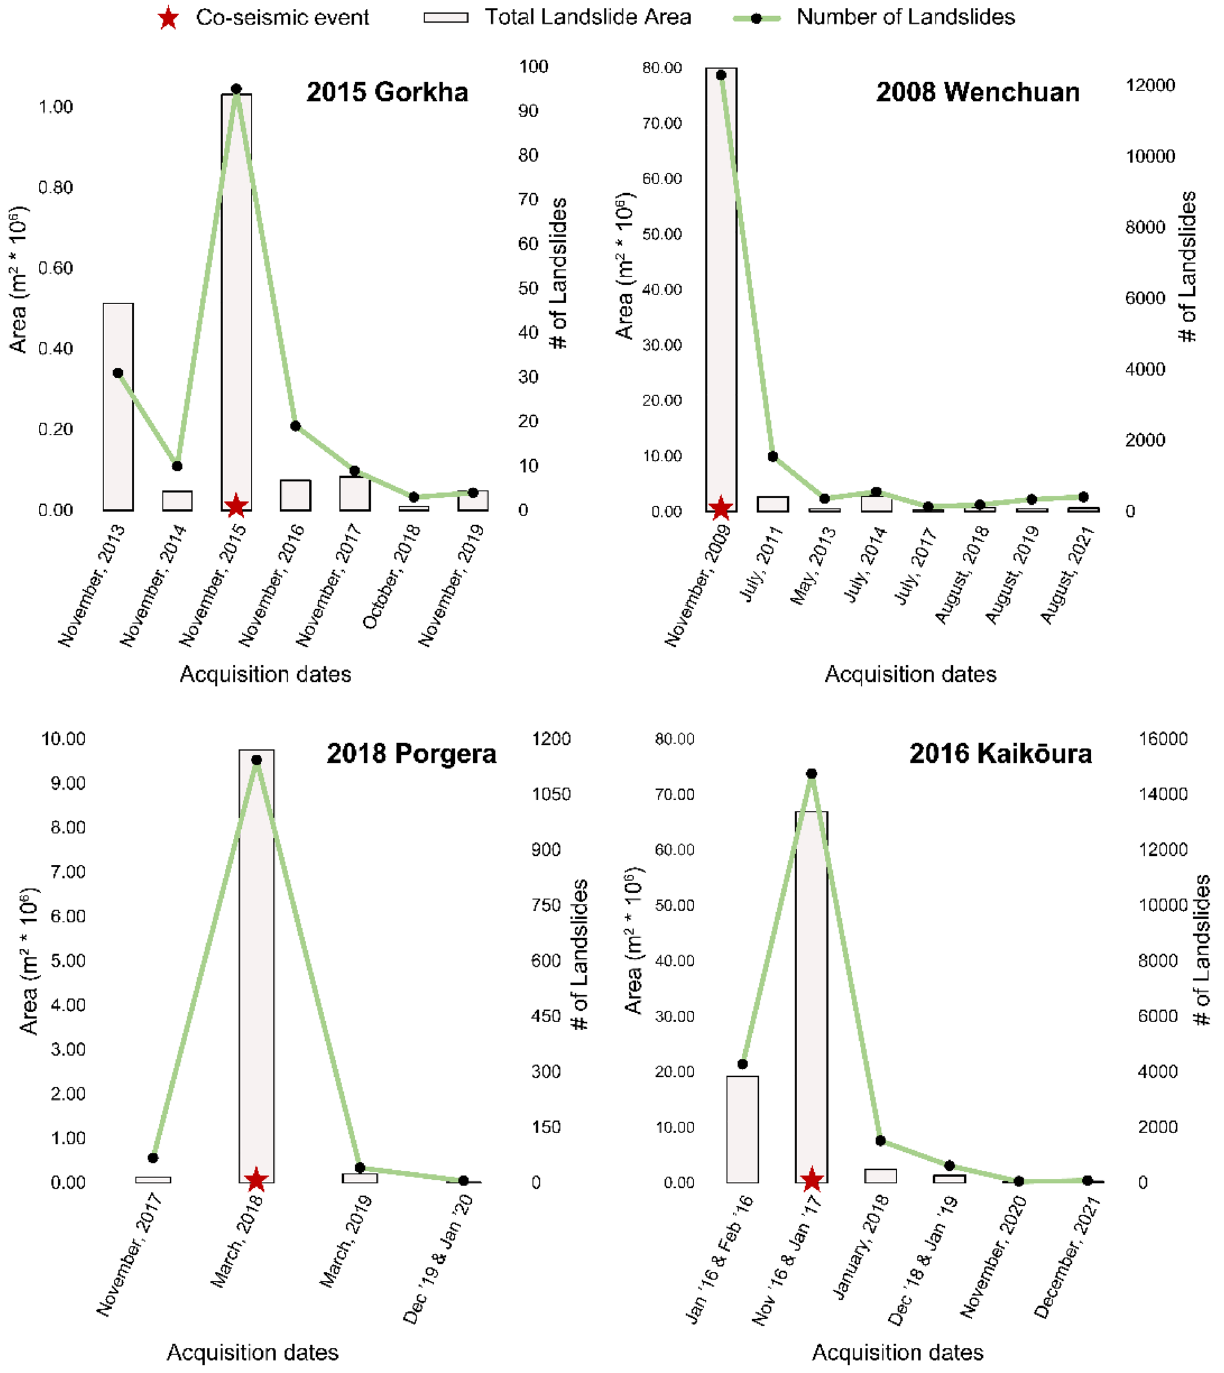
Figure 4. Trend of number of landslides and area of landslides through years for each study area detected by the